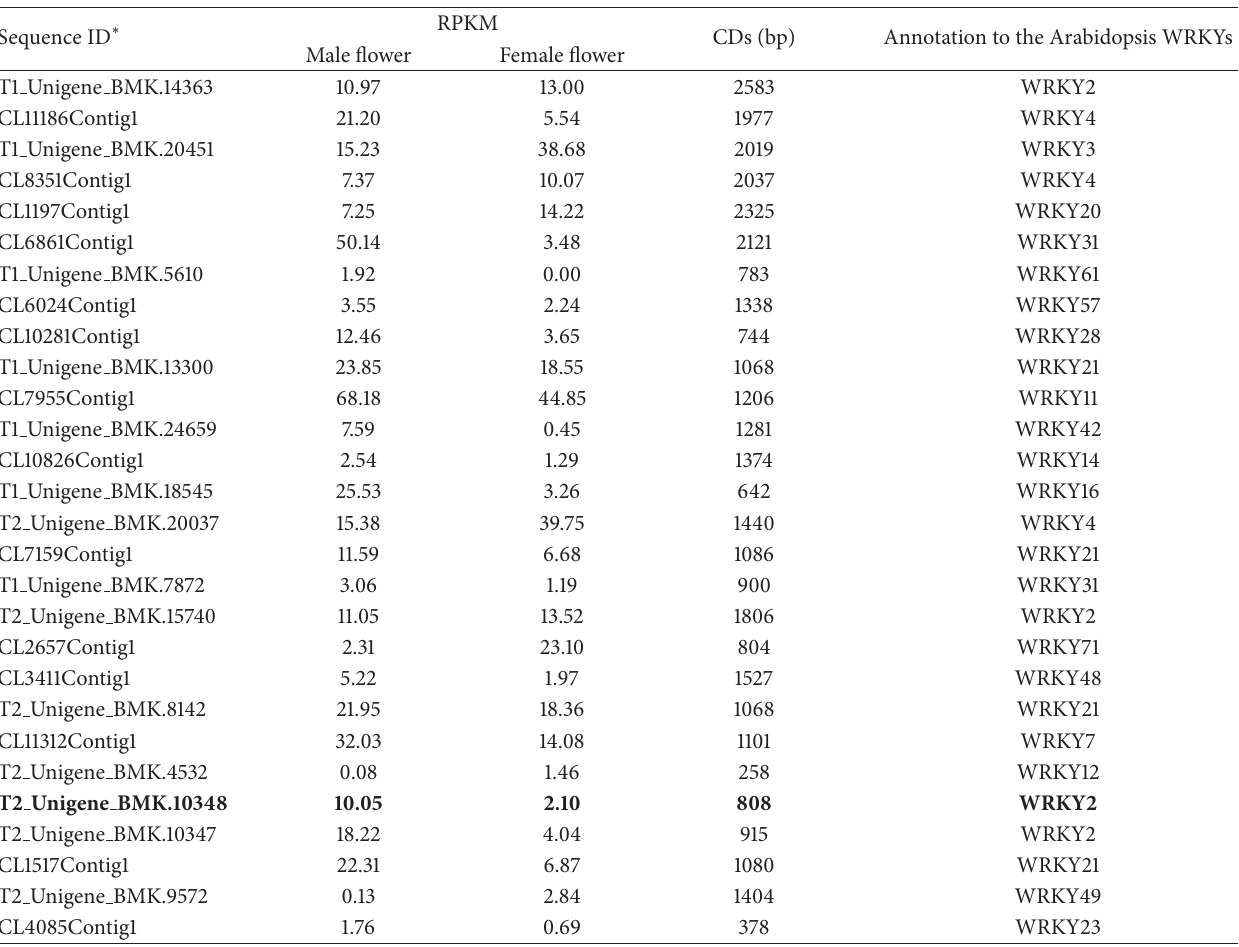
Table 2: The WRKY transcription factors in G. biloba